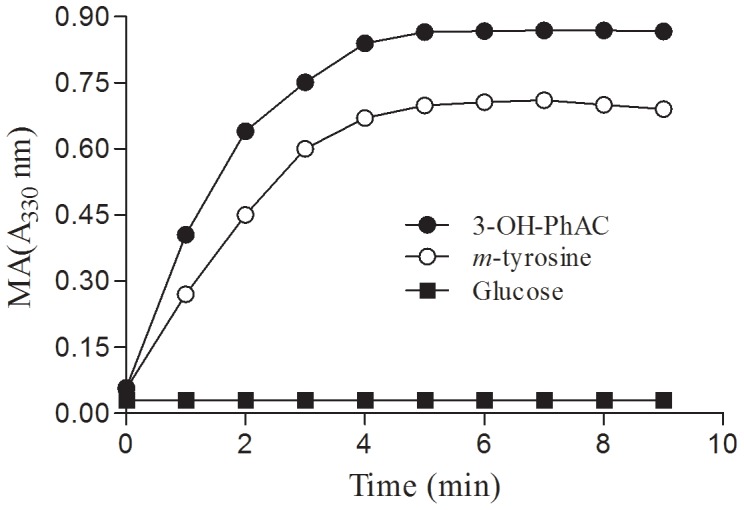
Homogentisate (HMG) 1, 2-dioxygenase activity from the cell-free lysates prepared from m-tyrosine-induced cells of strain SSC5.HMG 1, 2-dioxygenase activity was measured by maleylacetoacetate (MA) formation at 330 nm absorbance from cell-free lysates in spectrophotometer. (•), m-tyrosine grown cells; (○), 3-OH-PhAc grown cells; (▪), glucose grown cells.